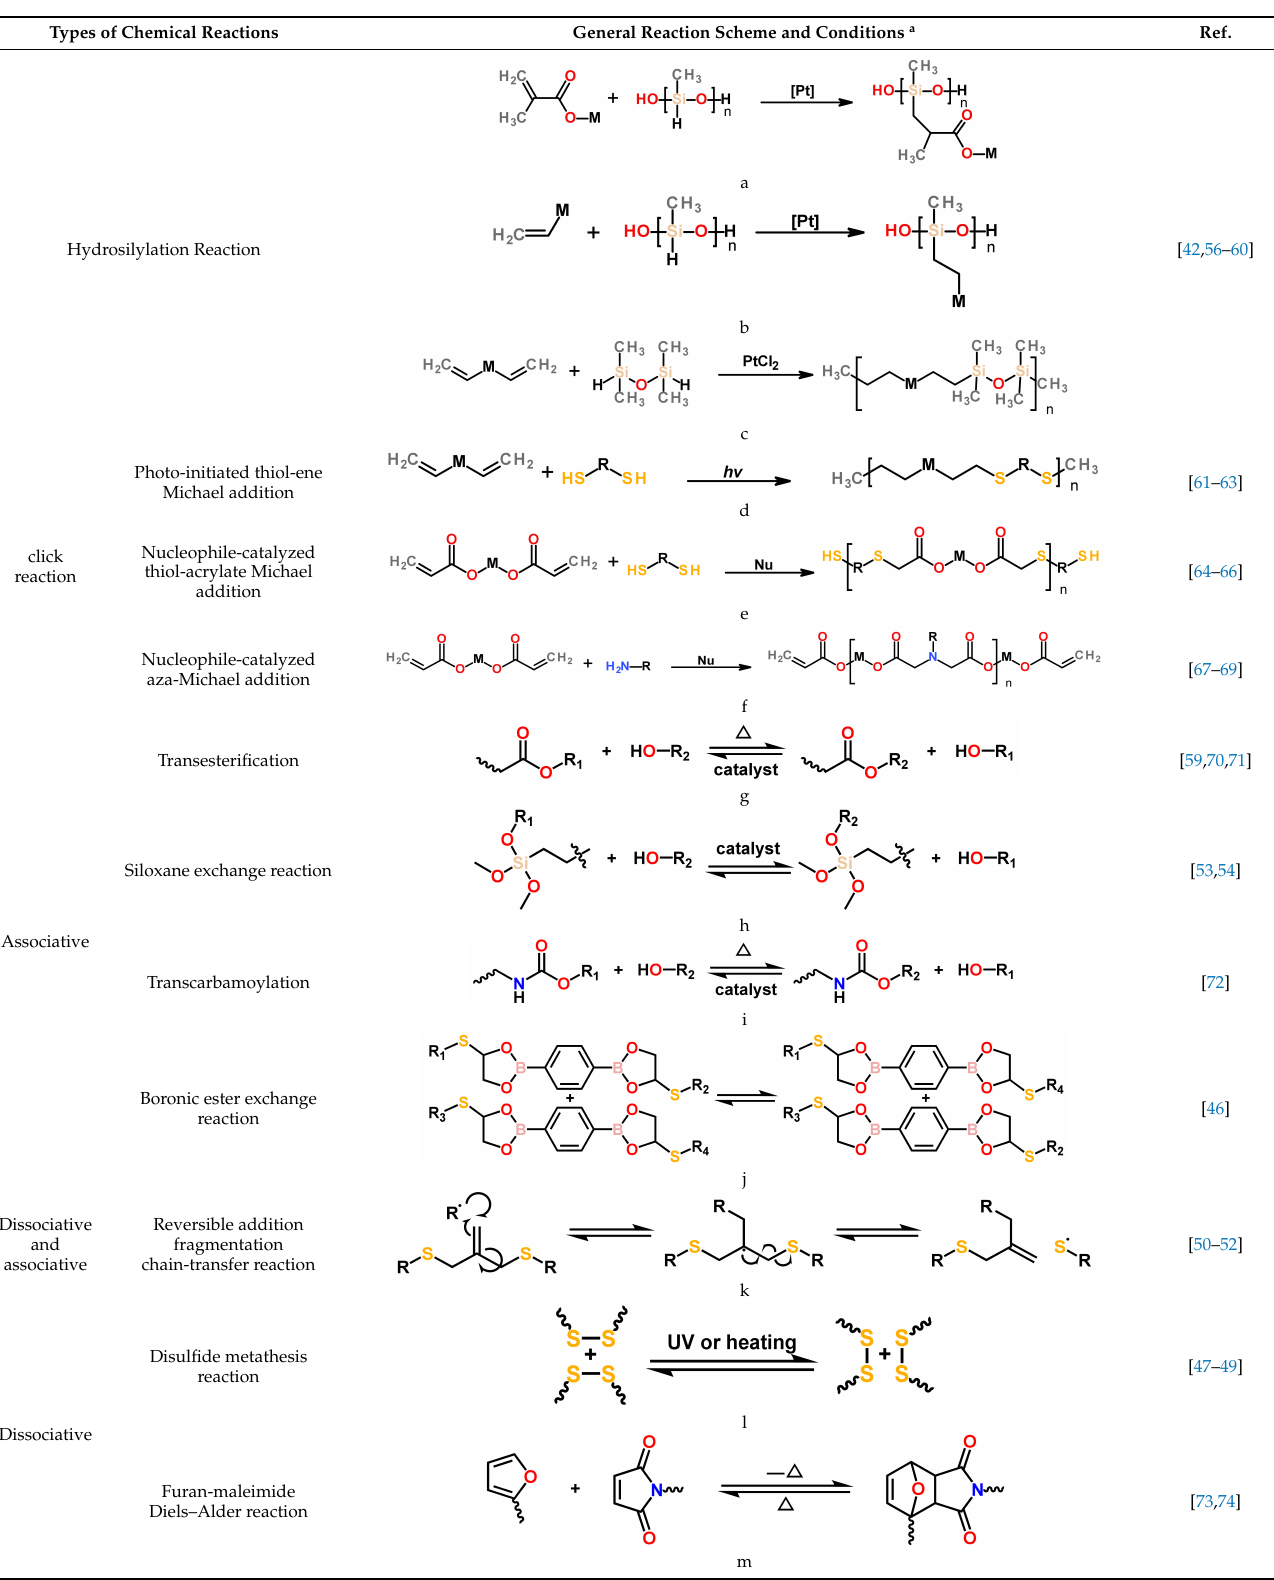
Table 1. Chemical reactions for liquid crystalline